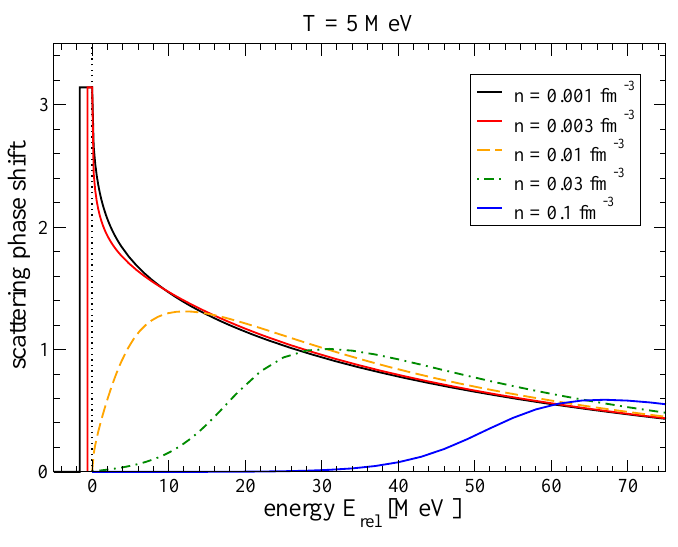
Figure 3. Integrand of the intrinsic partition function as function of the intrinsic energy in the deuteron channel. Different densities of the medium are considered, the temperature is T = 5 MeV. From